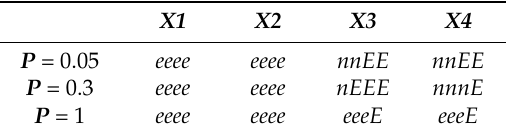
Table 2. Observed type of dynamics in the final phases of simulations of four Xr sets (top row) at three mutual defection payoffs (first column). For each { Xr , P } combination, simulations were performed at the mutation rates µ = {0.0001, 0.001, 0.01, 0.1}. In this alignment, letters { n , e , E } of the four-digit strings represents the dynamics found in simulations at respective rate; n : non-equilibrium dynamics, e : equilibrium in which only defectors obtain above average fitness, and E : equilibrium in which non-defectors obtain above average fitness (for example, eeeE means that equilibrium is found at all four rates whereby non-defectors attain above average fitness only at rate µ = 0.1). Fixed parameters: T = 5, S = 0, R = 3, K =